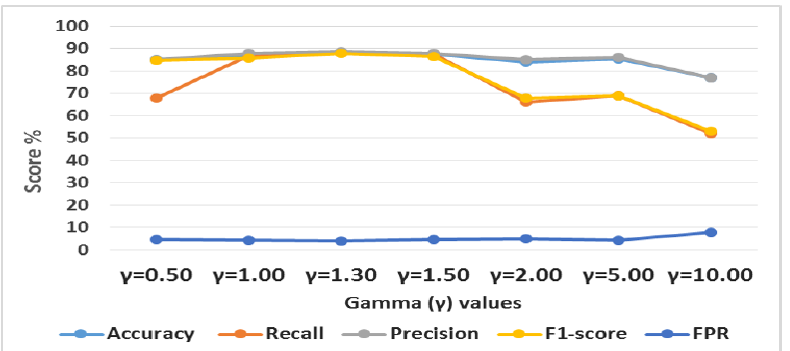
Figure 9. The result of intrusion detection performance with different Gamma ( γ ) values of Class-wise Focal